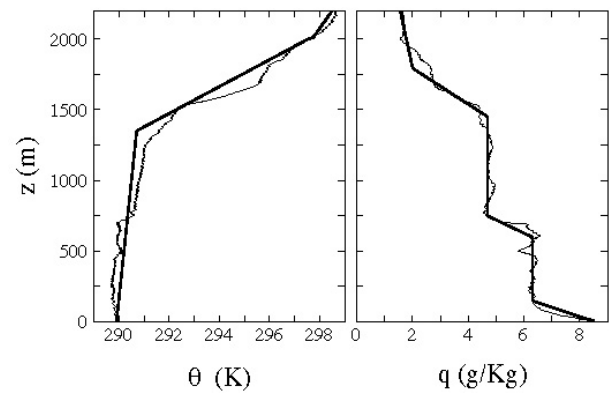
Fig. 5. Potential temporal and specific humidity initial profiles. Thinner curves are from the radiosounding at t 0 = 08:48UTC of 16 June 1992, while thicker lines are the curves fitting the experi- mental ones that were used to initialize the LES